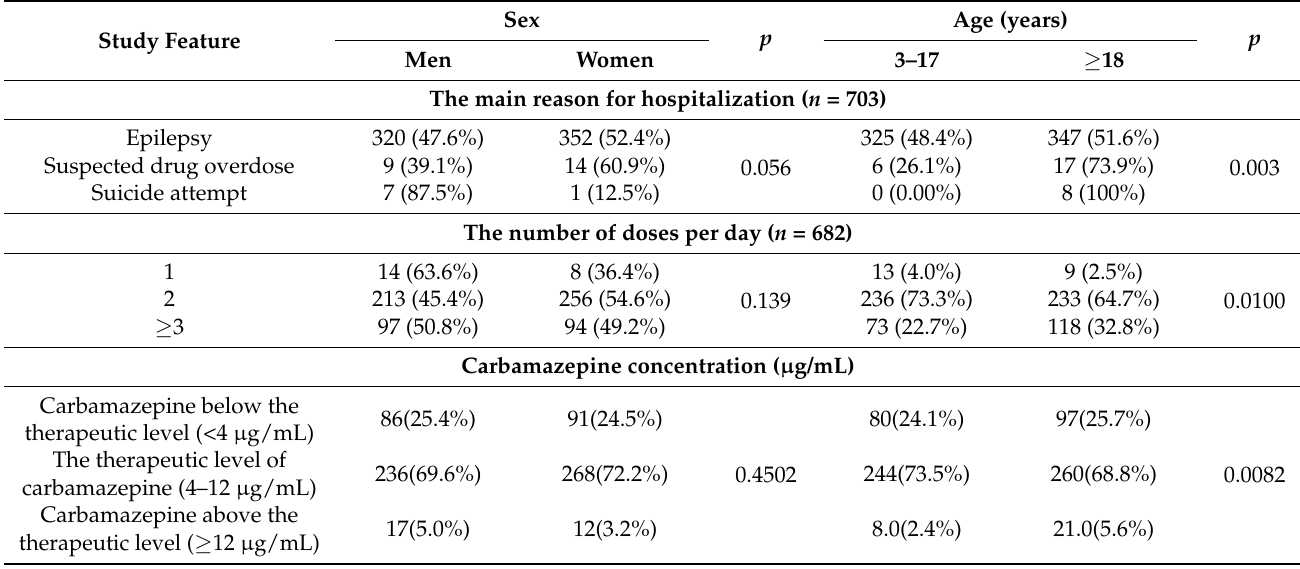
Table 4. Daily carbamazepine dose and the main reason for hospitalization of the study population depending on age and sex (median (lower quartile-upper quartile) or number (percent)). Study